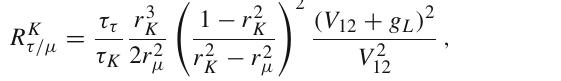
= 1 . 5TeV. The red dot marks the position 1